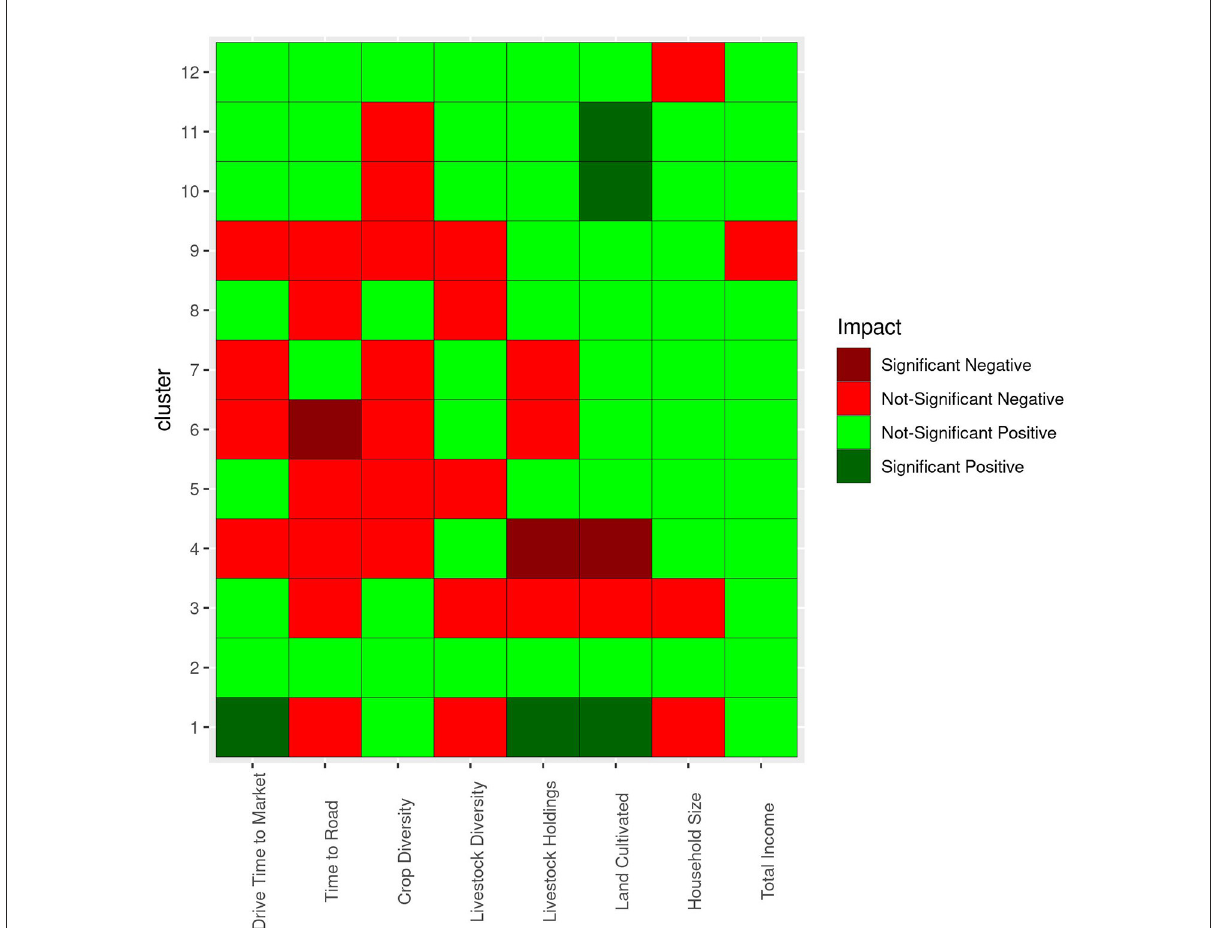
FIGURE4 Statistical significance of the impact of each variable on the Household Dietary Diversity Score for each